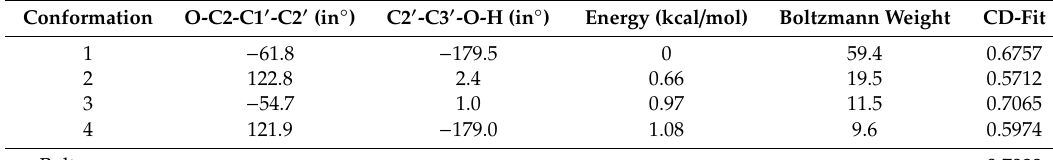
Table 3. Results of DFT calculations for the (2 R ,3 R ) enantiomer of compound 3 .